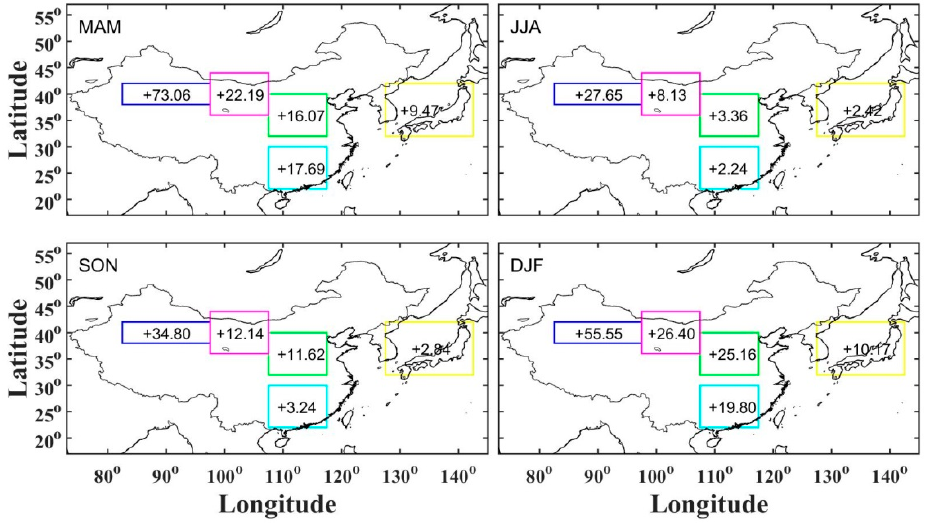
Figure 8. Seasonal distribution of horizontal dust transport flux (Tg) over East Asia (dark blue box: Taklimakan Desert, magenta box: Gobi Desert, green box: Northern China, light blue box: Southern China and yellow box: Korea-Japan).